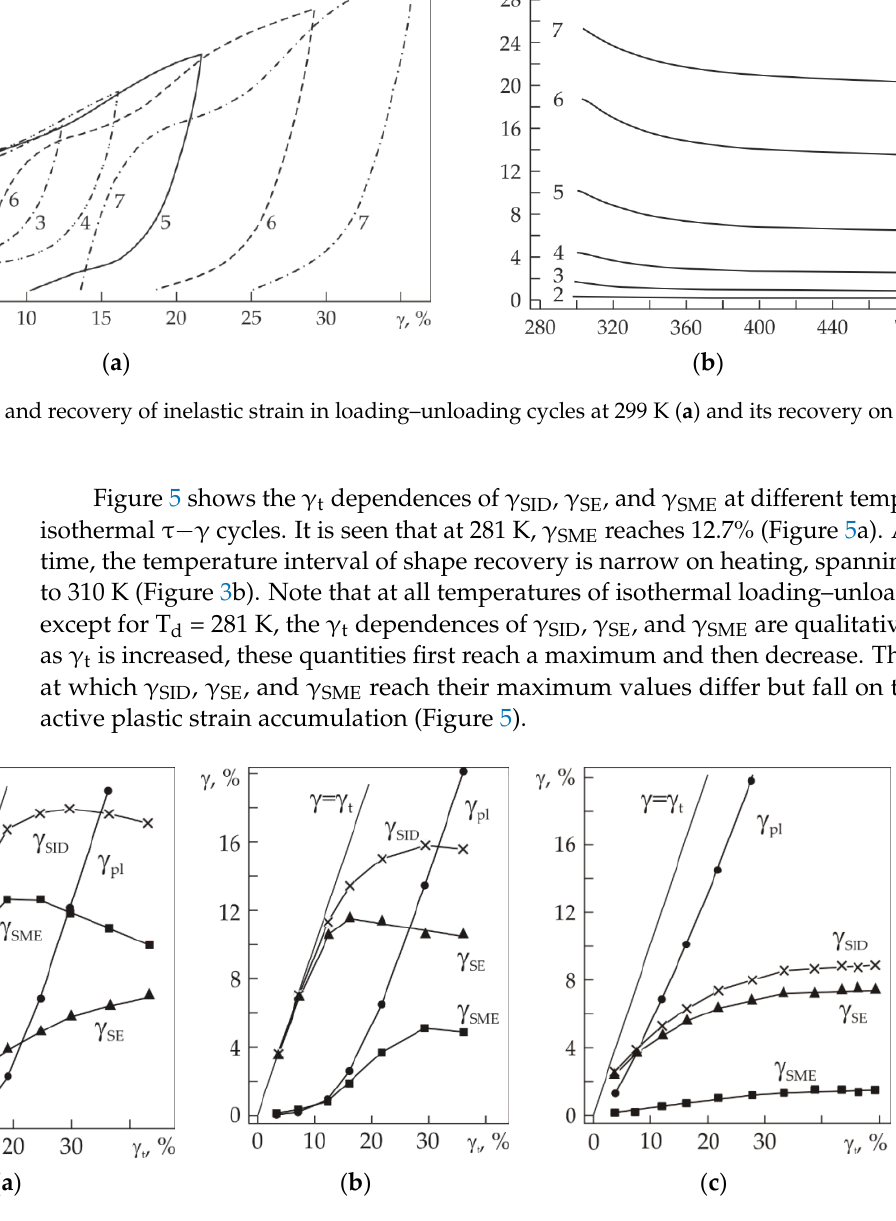
Figure 5. Dependences of γ SE ( ▲ ), γ SME ( ■ ), γ SID (×), and γ pl (●) on γ t after isothermal loading-unloading at 281 K ( a ), 299 K ( b ), 339 K ( c ) and subsequent heating of unloaded specimens.